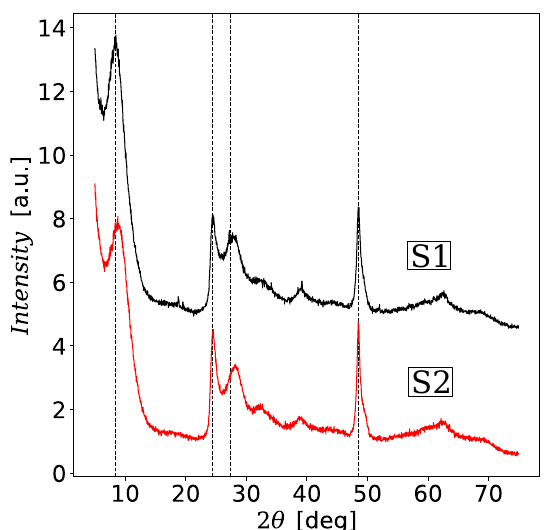
Figure 2. Wide-angle XRD patterns of unmodified titanate nanotubes (TNTs) (sample S1) and modified TNTs (sample S2). The plots have been shifted relative to each other for greater clarity. Dashed vertical lines indicate slight differences in the peaks between S1 and S2 samples such as their location, shape or height.